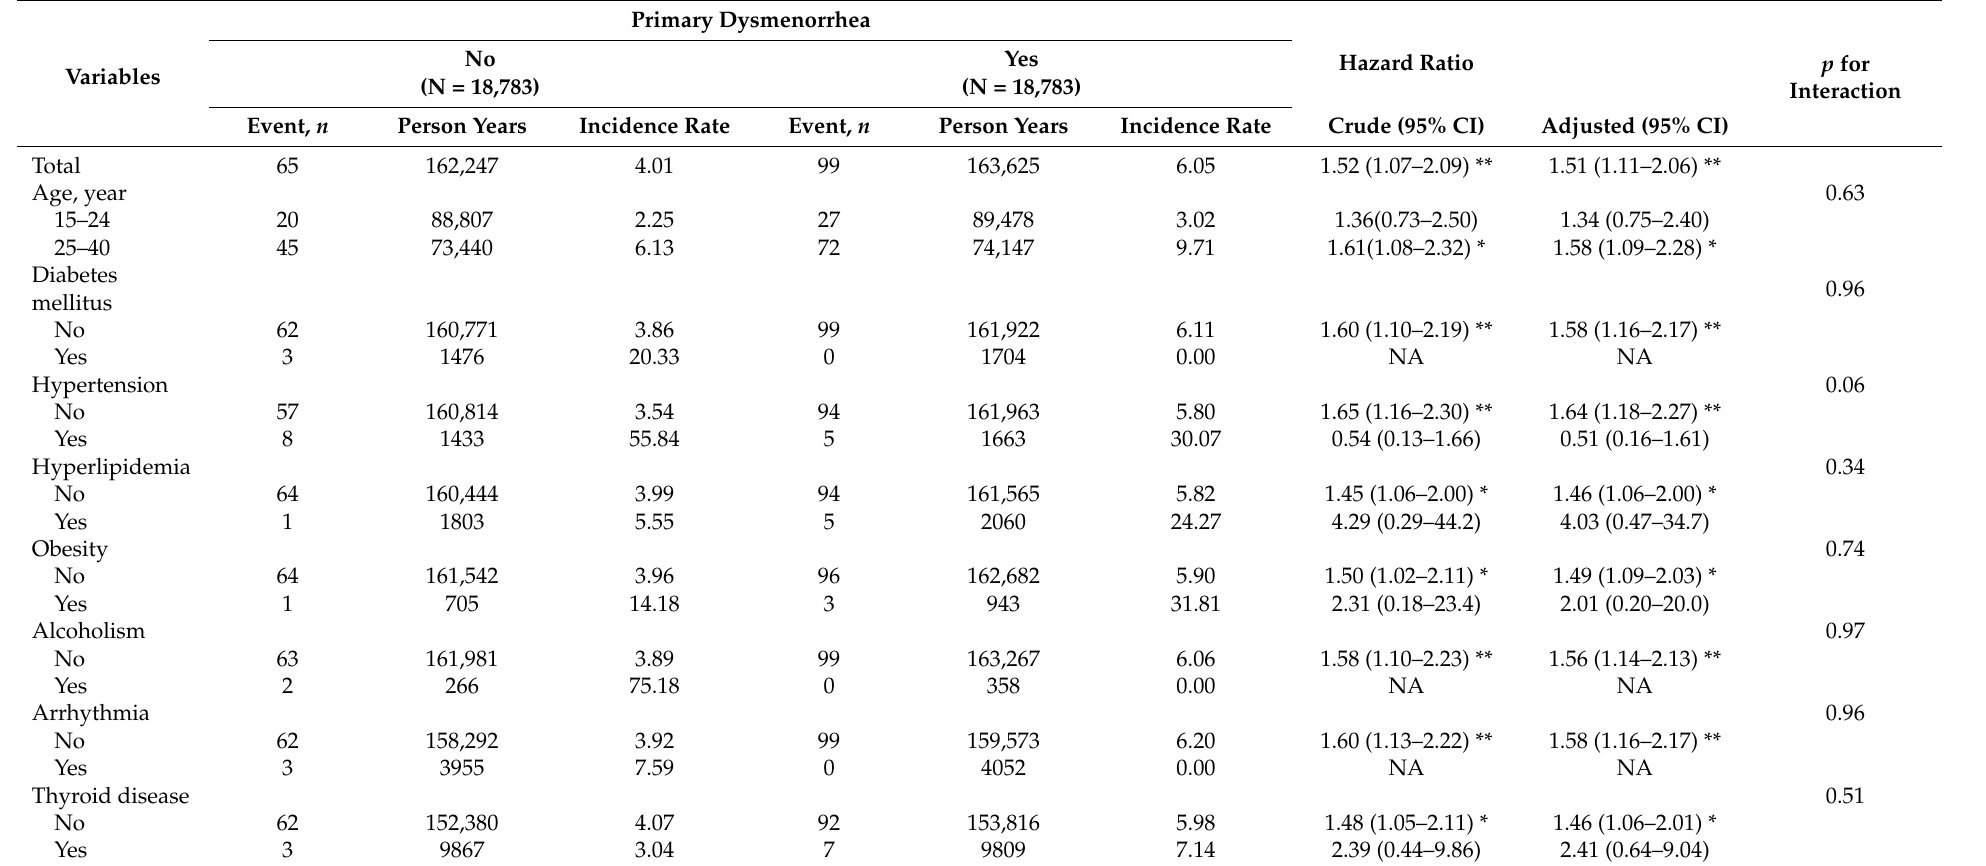
Table 2. Overall number of stroke events and incidence rates in primary dysmenorrhea and comparison cohorts by age, comorbidity, and NSAID use, and Cox model estimated primary dysmenorrhea cohort to comparison adjusted hazard ratio and 95% confidence